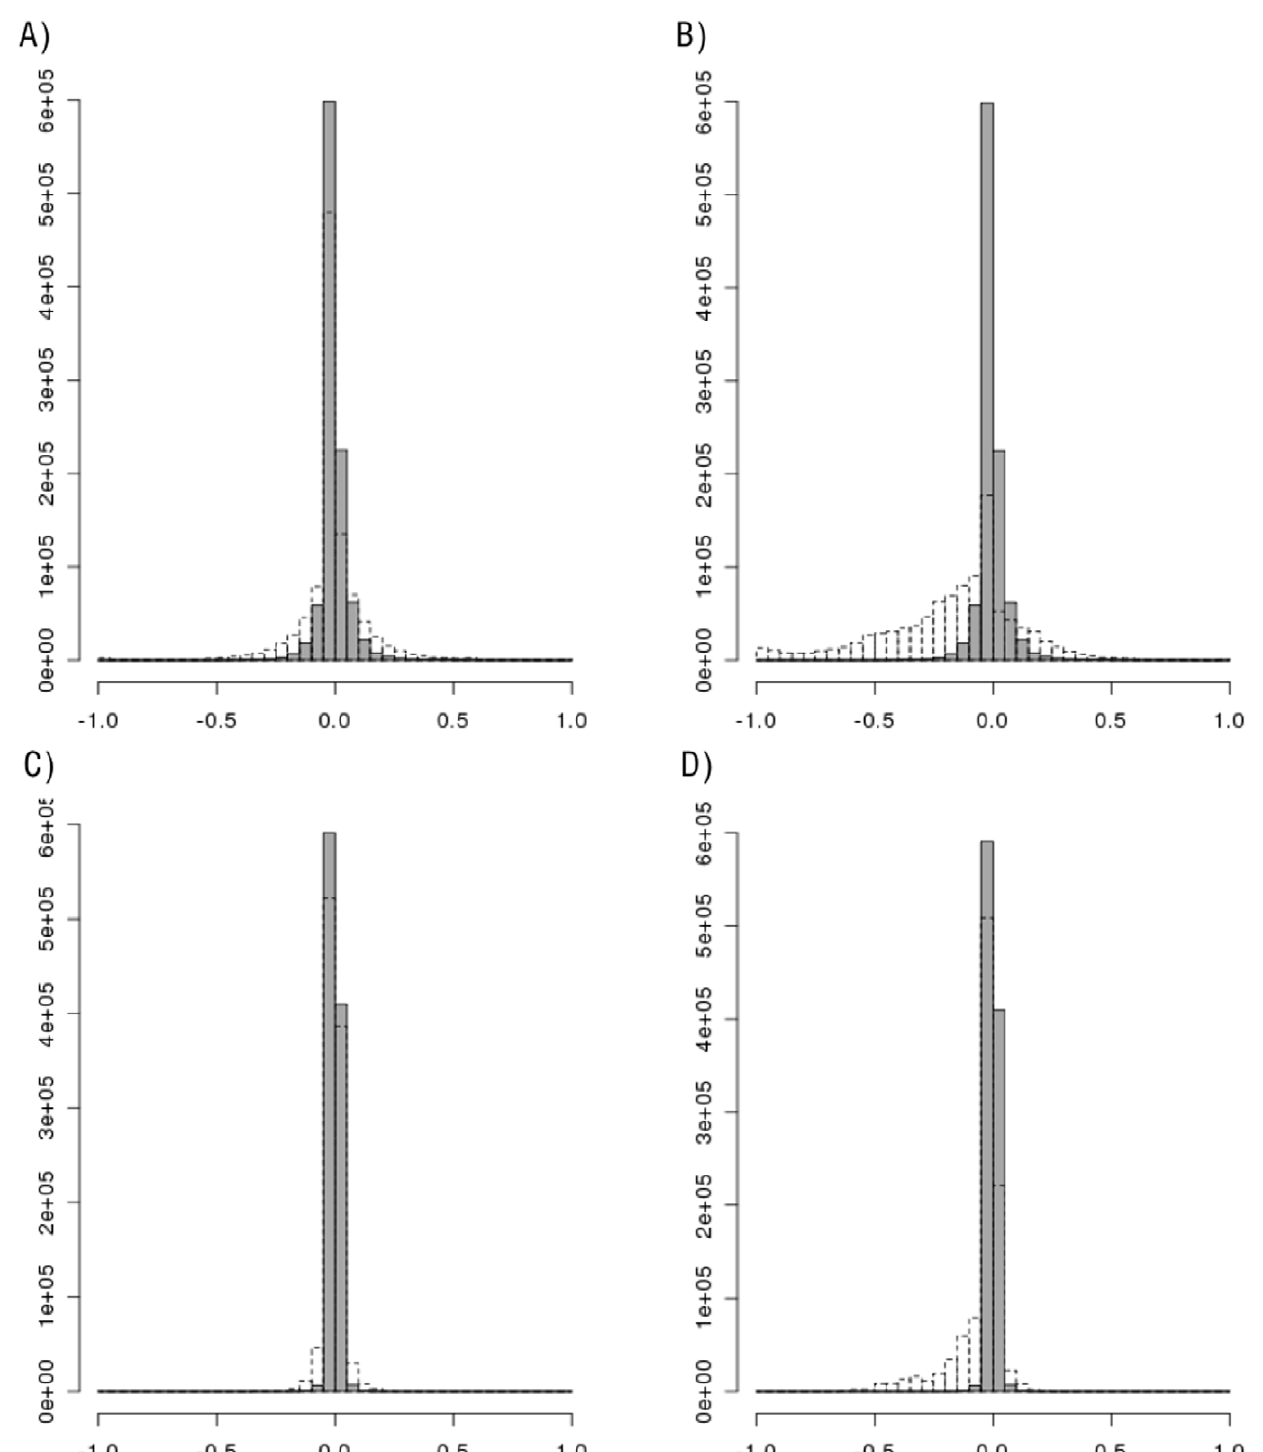
Figure 2. Histograms of the change in LD for each pair of SNPs in Gene Region 1. Histograms of the change in simulated LD from original LD for each pair of SNPs in Gene Region 1 (LD simulated – LD HapMap ). A) D’, Resampling (gray) vs Hapgen (dotted); B) D’, Resampling (gray) vs HapSim (dotted); C) r 2 , Resampling (gray) vs Hapgen (dotted); D) r 2 , Resampling (gray) vs HapSim (dotted). doi:10.1371/journal.pone.0040925.g002 probability of continuing on the current haplotype segment or rate across the region as well as the effective population size transitioning to a randomly chosen haplotype segment. The [20,21]. Each newly created haplotype is added to the set of transition probabilities are defined by the variable recombination original haplotypes from which more haplotypes are created.